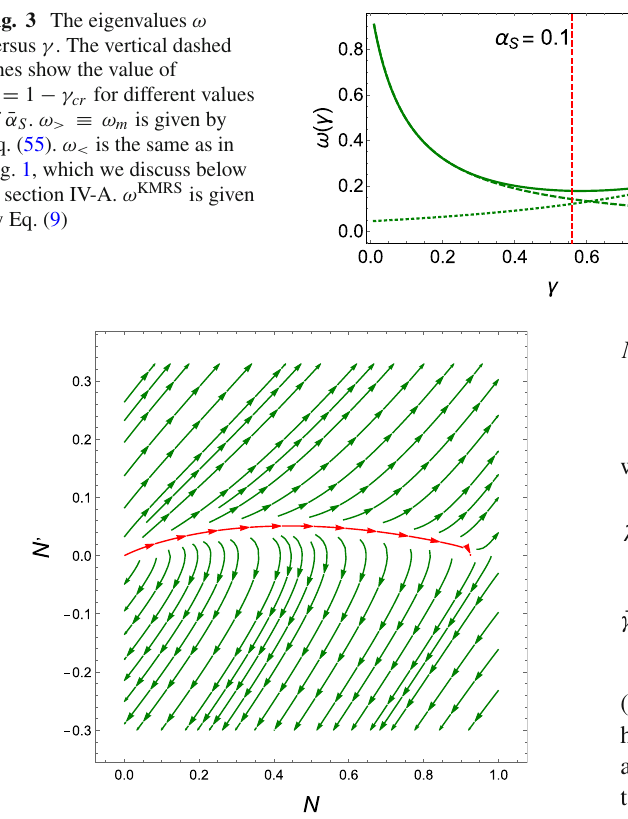
Fig. 4 The phase portrait of Eq. (57) (or Eq. (58)).The unique hetero- clinic orbit for this equation is shown in